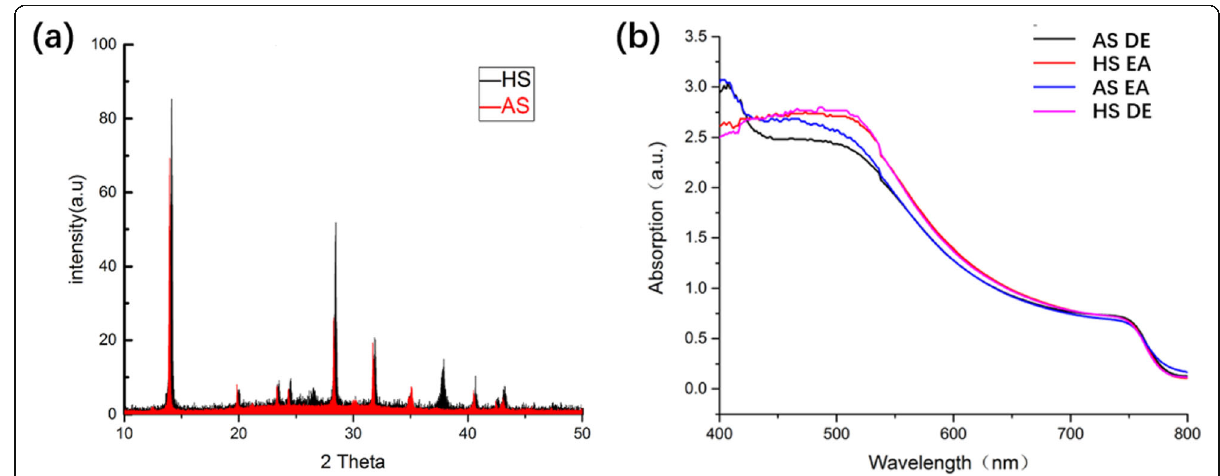
Fig. 6 a XRD pattern of HS-perovskite and AS-perovskite. b UV-visible light absorption curves of different perovskite